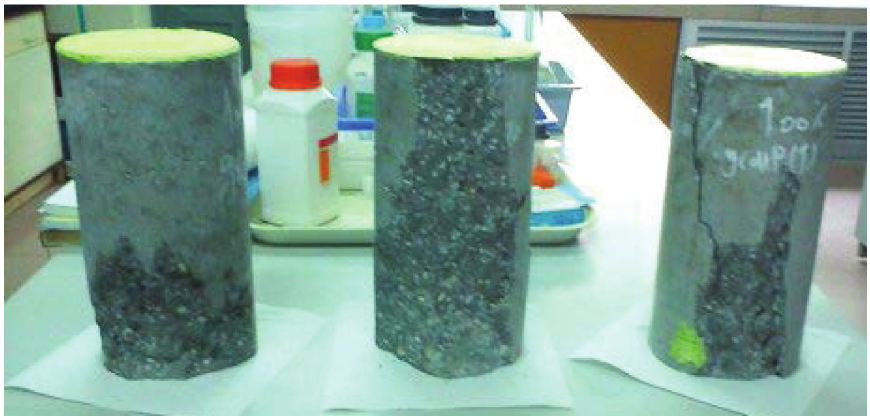
Fig. 2. Defected specimens with level of 100% pre-damage